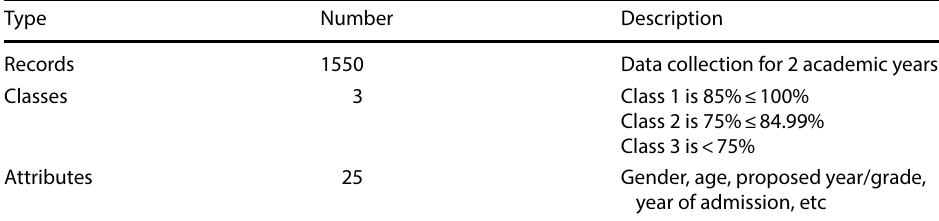
Table 1 Sample of student dataset